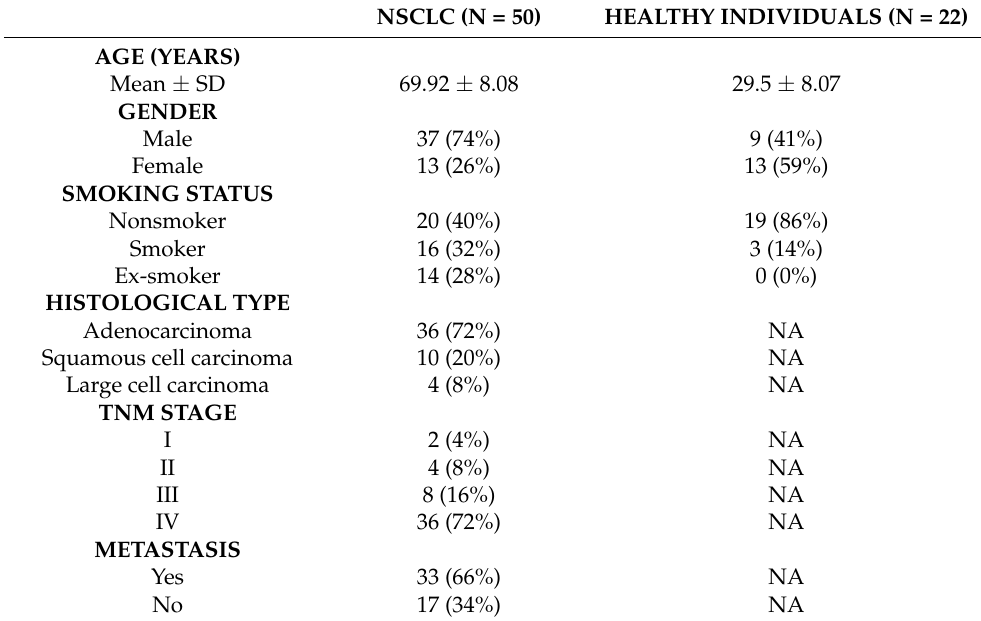
Table 1. Characterization of lung cancer patients and healthy individuals enrolled in the